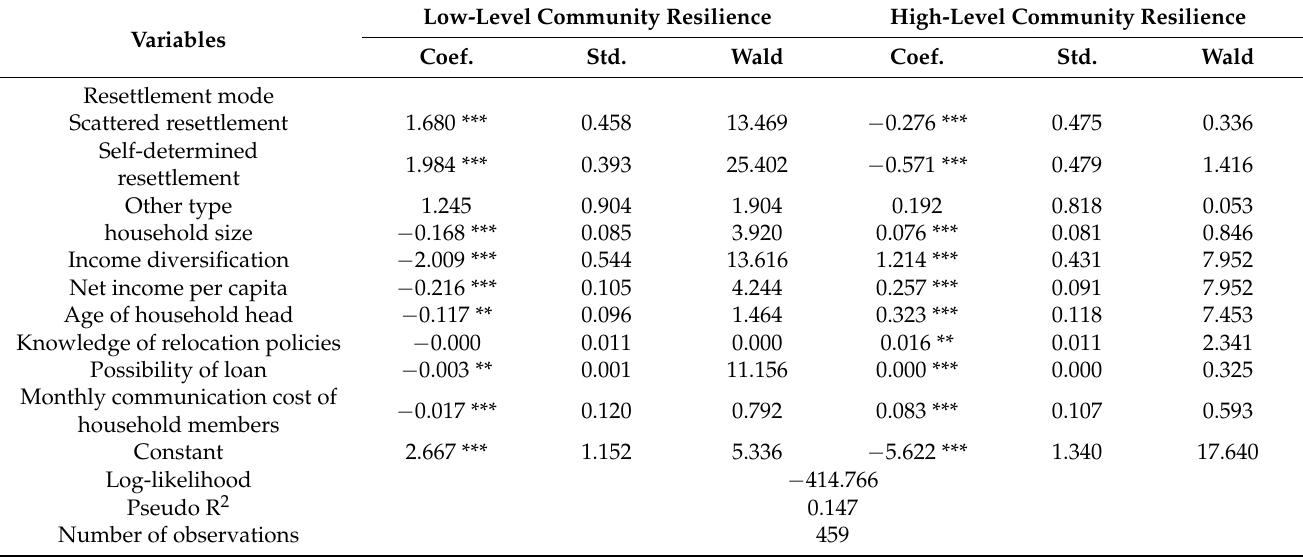
Table 6. The effect of the resettlement mode on the community resilience of relocated households in the case of